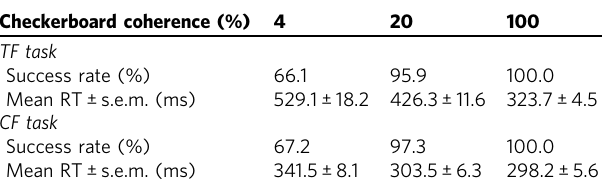
continued presence after the targets appeared until the monkey initiated a reach.